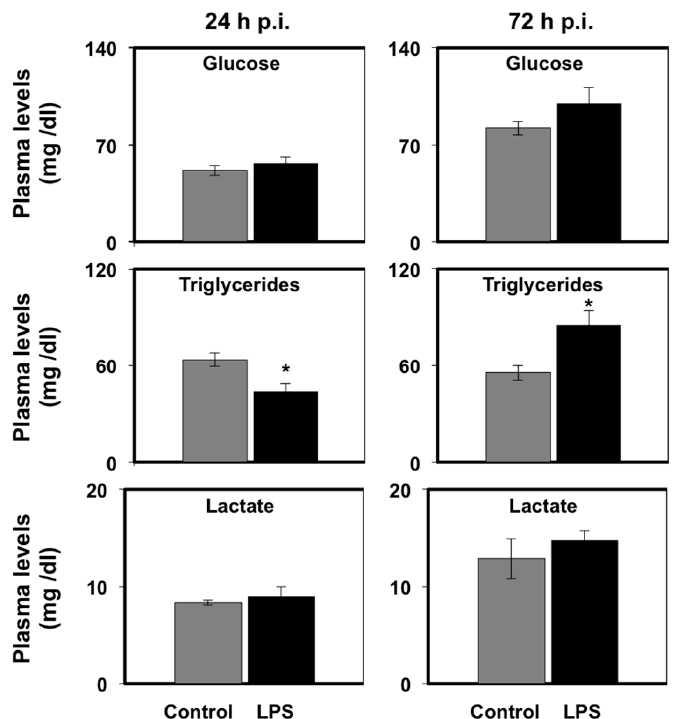
Figure 1. Effects of lipopolysaccharide (LPS) administration in vivo on plasma metabolite levels in seabream. Glucose, triglyceride, and lactate levels in plasma were measured at 24 and 72 h after saline (grey bars) or LPS (black bars) injection. Values shown are means ± SE of five fish per group, each analyzed in triplicate. Significant differences between control and treatment groups are shown with asterisks ( p <